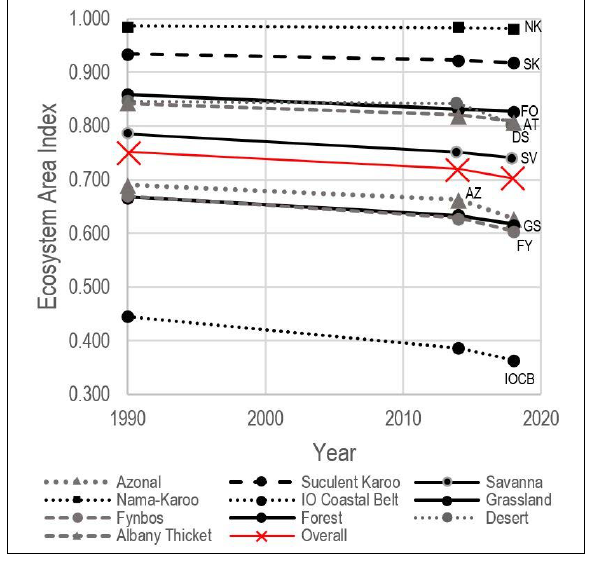
Figure 3: Ecosystem Area Index (EAI) for terrestrial ecosystems of South Africa: 1990, 2014 and 2018. There has been an overall decline of 7% across the whole of South Africa (1990–2018). For Fynbos, Grassland, Azonal vegetation and the Indian Ocean Coastal Belt, relative decline in EAI is most severe over the period from 2014 to 2018.